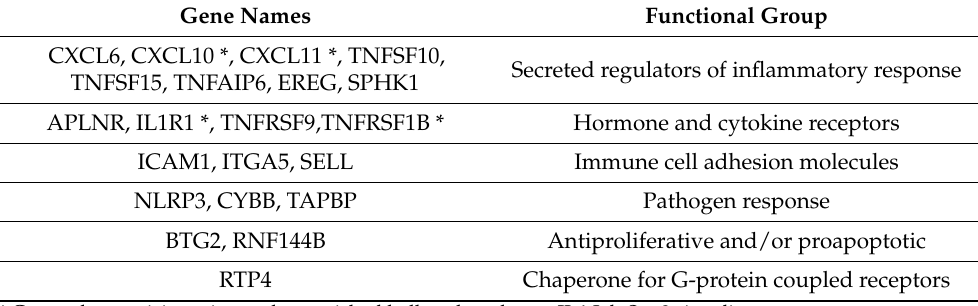
Table 2. Genes differentially expressed uniquely in the DBTRG-05MG cell line after interferon α 2 β treatment and attributed to the hallmark inflammatory response pathway [27], which is most enriched in this group of genes. Functional groups are defined by biocuration based on annotations of GeneCards